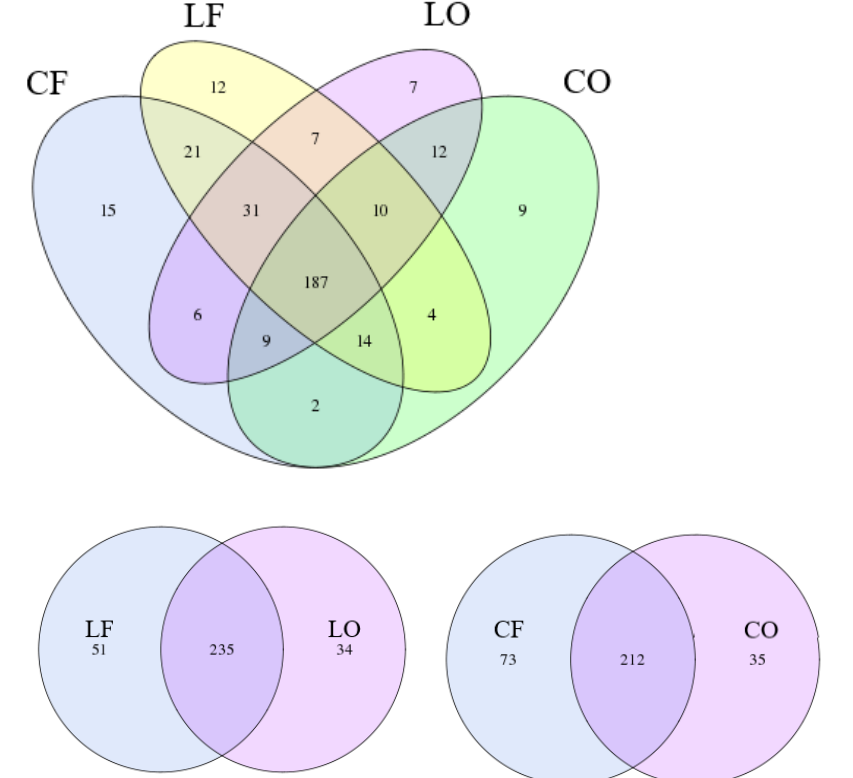
Figure 4. Venn diagrams representing unique and shared operational taxonomic units (OTUs) in hamsters fed one of the four diets: CF, fresh corn oil; CO, oxidized corn oil; LF, fresh lard; LO, oxidized lard.